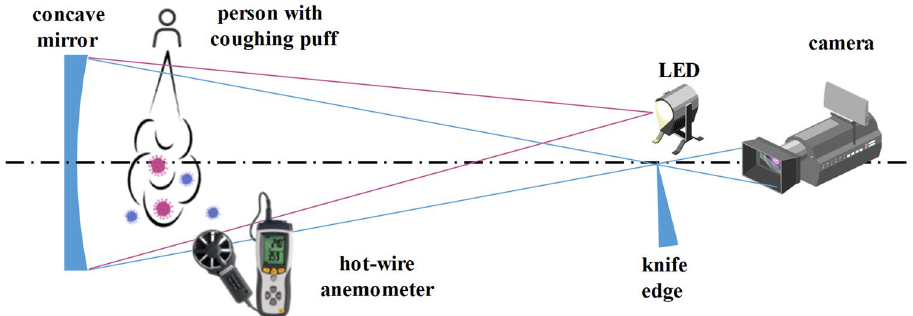
Figure 15. Components of the Schlieren imaging system. The figure was drawn in Adobe Illustrator (version